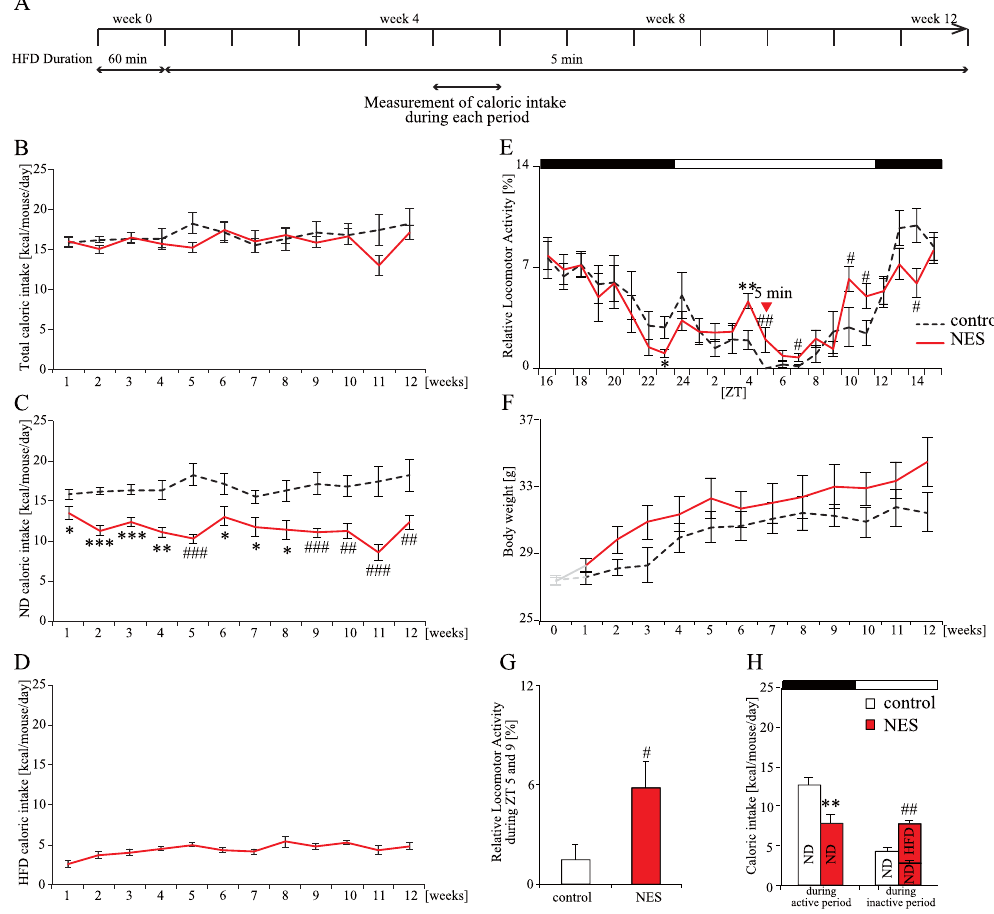
Figure 2. Effect of 5-min RF with HFD at ZT 5 on locomotor activity, body weight, and caloric intake (Experiment 2). ( A ) Experimental schedule. ( B – D ) Change in average caloric intake of total ( B ), ND ( C ), and HFD ( D ) under 5-min RF. ( E ) Relative locomotor activity rhythm under 5-min RF with HFD at ZT 5. Red triangle represents the start of RF. Open and closed bars indicate light and dark periods, respectively. ( F ) Increase in body weight. Gray period indicates under-habituation. ( G ) Sum of relative locomotor activity during ZT 5 and 9. ( H ) Caloric intake during each period for ND and HFD. ND and HFD are shown in every bar. Data are presented as the mean ± SEM ( n = 8). * p < 0.05, ** p < 0.01, *** p < 0.001 vs. the control group (Student’s t - test); # p < 0.05, ## p < 0.01, ### p < 0.001 vs. the control group (Mann-Whitney